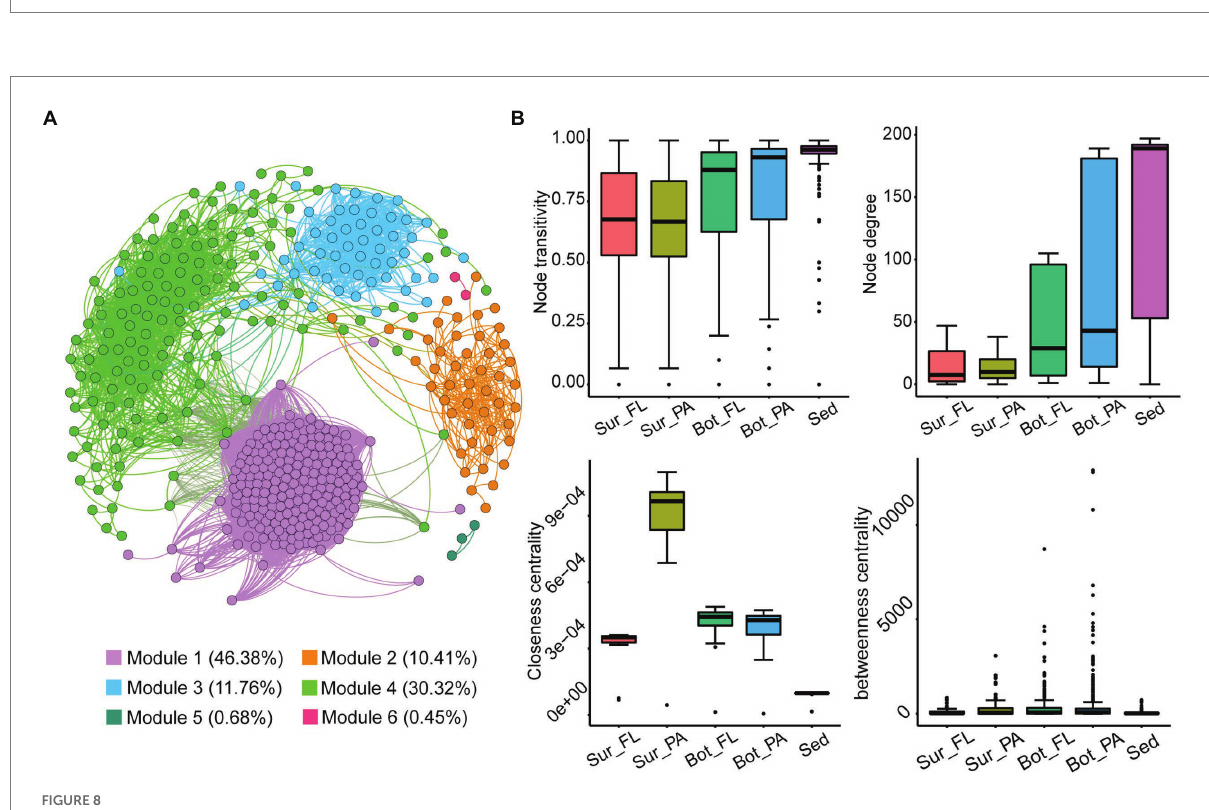
FIGURE 8 Co-occurrence networks of the microbial community in all samples and topological properties. (A) OTU level co-occurrence network; (B) Comparison of node-level topological features among